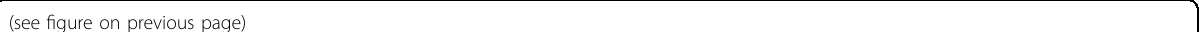
Fig. 1 Loss of NR2F6 fosters the formation of antigen-speci fi c CD8 + memory T cells and promotes an enhanced antigen recall effector cytokine response after LmOVA infection. A Nr2f6 + / + or Nr2f6 − / − mice were infected with 1 × 10 4 CFU LmOVA. The frequency of antigen-speci fi c (CD44 + OVA tet + ) cells was monitored in the blood for up to 70 d.p.i. Representative plots of CD44 + OVA tet + gated out of CD8 + T cells (left and middle) are shown on days indicated and total cell numbers per 50 μ l of blood on day 70 (right). B Nr2f6 + / + and Nr2f6 − / − total number of cells (×10 5 ) per mg of spleen, 70 d.p.i. C Representative plots and quanti fi cation of CD44 + OVA tet + speci fi c CD8 + T cells in the spleen on 70 d.p.i. and the total number of CD44 + OVA tet + speci fi c CD8 + T cells (×10 2 ) per mg spleen. D Representative plots and quanti fi cation of CD127 and CD122 expression within CD8 + CD44 + OVA tet + cells and numbers of memory CD8 + CD44 + OVA tet + CD122 + CD127 + cells (×10 2 ) per mg spleen, 70 d.p.i. E Representative plots and quanti fi cation of KLRG1 and CD127, and CXCR3 within CD127 + KLRG1 − cells, all gated out of CD8 + CD44 + OVA tet + cells and total numbers of CXCR3 + cells from the previous gates, shown as cells per mg of the spleen (×10 2 ). F Representative plots and quanti fi cation of T central memory (Tcm) CD44 + CD62L + and T effector memory (Tem) CD44 + CD62L − expression gated out of CD8 + CD44 + OVA tet + cells. G Representative dot plots depicting cytokine production within splenic CD8 + T cells d70 after LmOVA infection with N4 recall ex vivo for 4 h, in the presence of Brefeldin A. Graphs show quanti fi cation of Nr2f6 + / + or Nr2f6 − / − CD8 + T cells cytokine production as %, as total IFN- γ + TNF- α + IL-2 + producing cells per spleen (total cell numbers). Representative data shown are from one independent, out of at least two replicative experiments, with n = 3 per group and experiment. Each dot represents the data of an individual mouse. Results are shown as mean ± SD. An asterisk indicates statistically signi fi cant differences between genotypes calculated using Student ’ s t test or two-way ANOVA (A). A p value < 0.05 was considered statistically signi fi cant. * p < 0.05; ** p < 0.01; *** p < 0.001; ns = not signi fi cant; d.p.i.: days